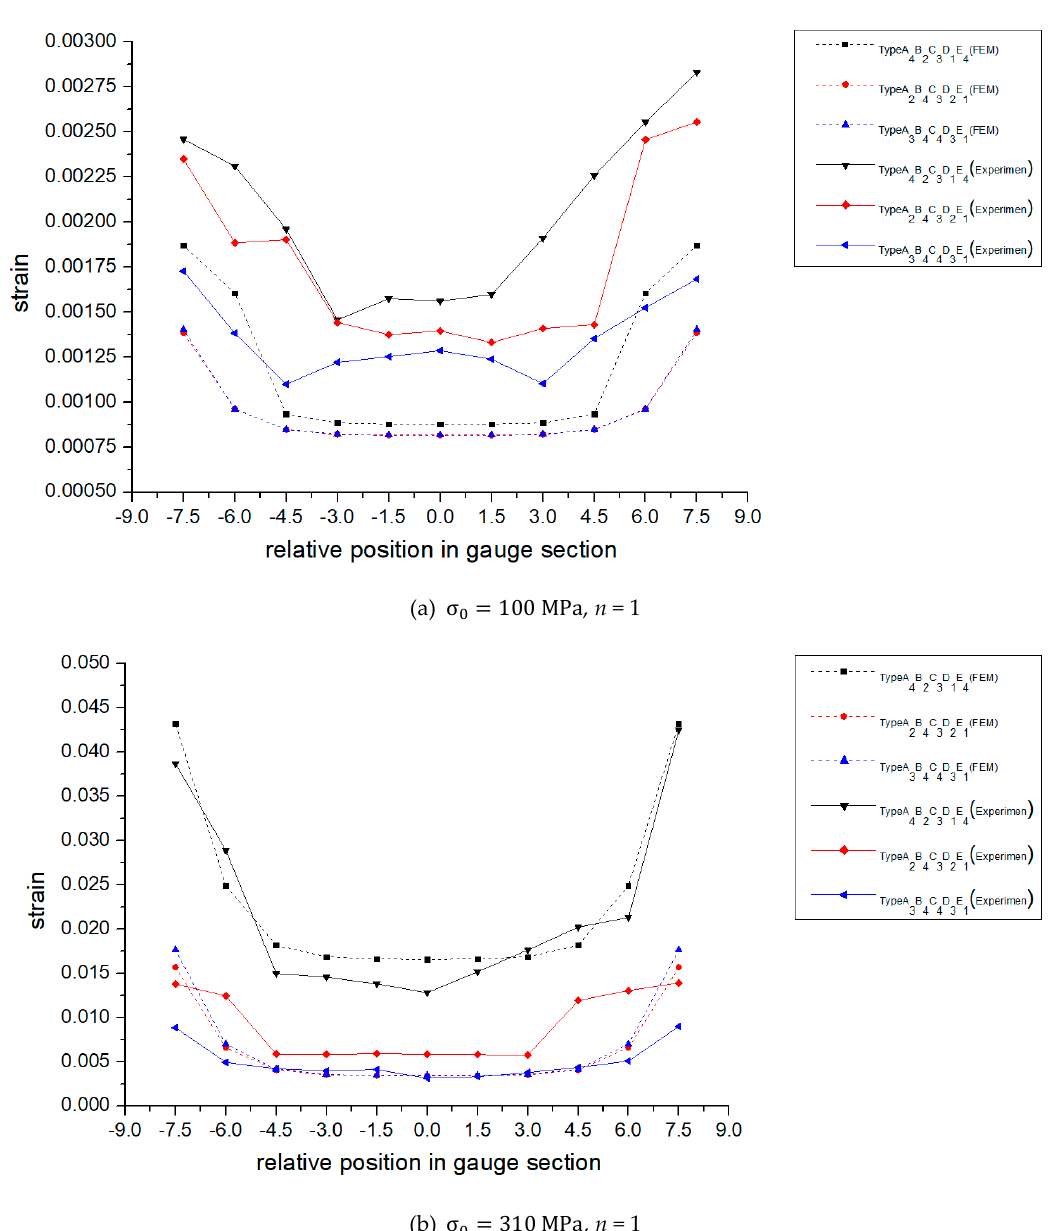
Figure 17. The Mises strain distributions along the diagonal line in the three cruciform geometries. The results of FEM are presented for comparison.